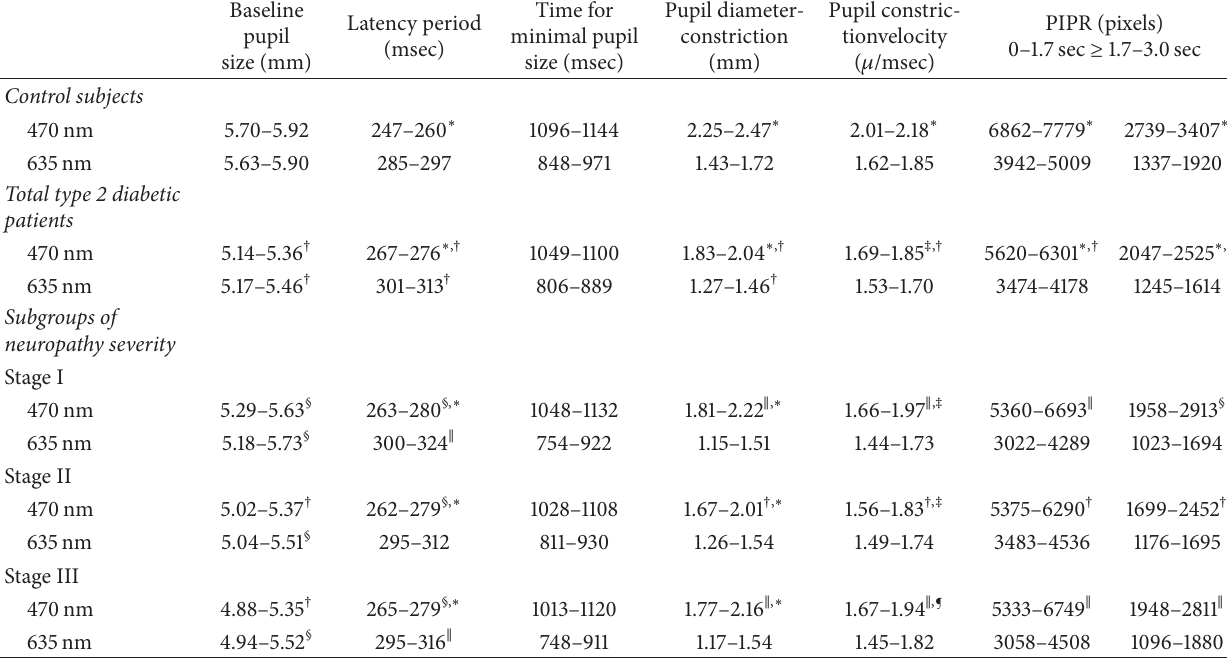
Table 4: Comparison of the parameters of pupillary light reflex between control subjects, type 2 diabetic patients, or their subgroups stratified by the severity of